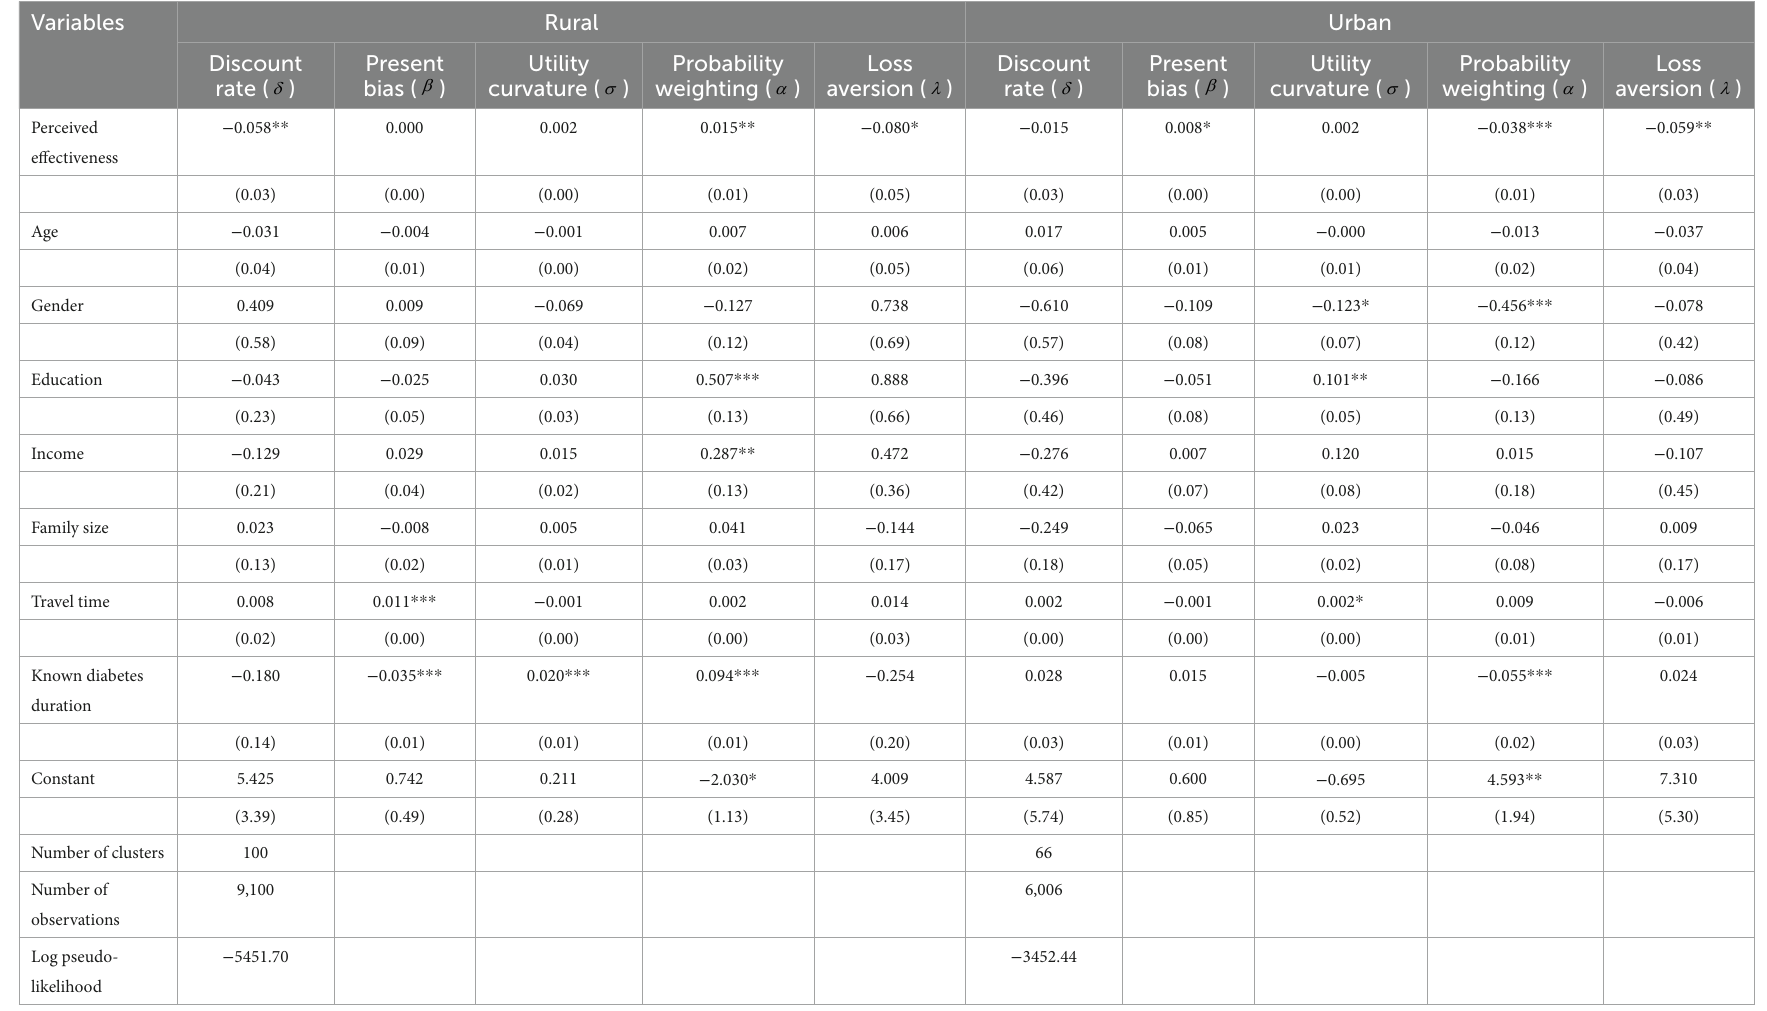
TABLE 5 Association between risk and time preferences and perceived effectiveness of intervention